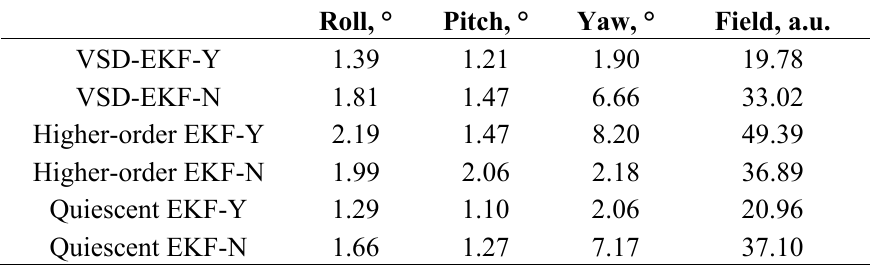
Table 4. Euler angles and magnetic distortion RMSE (dynamic test).